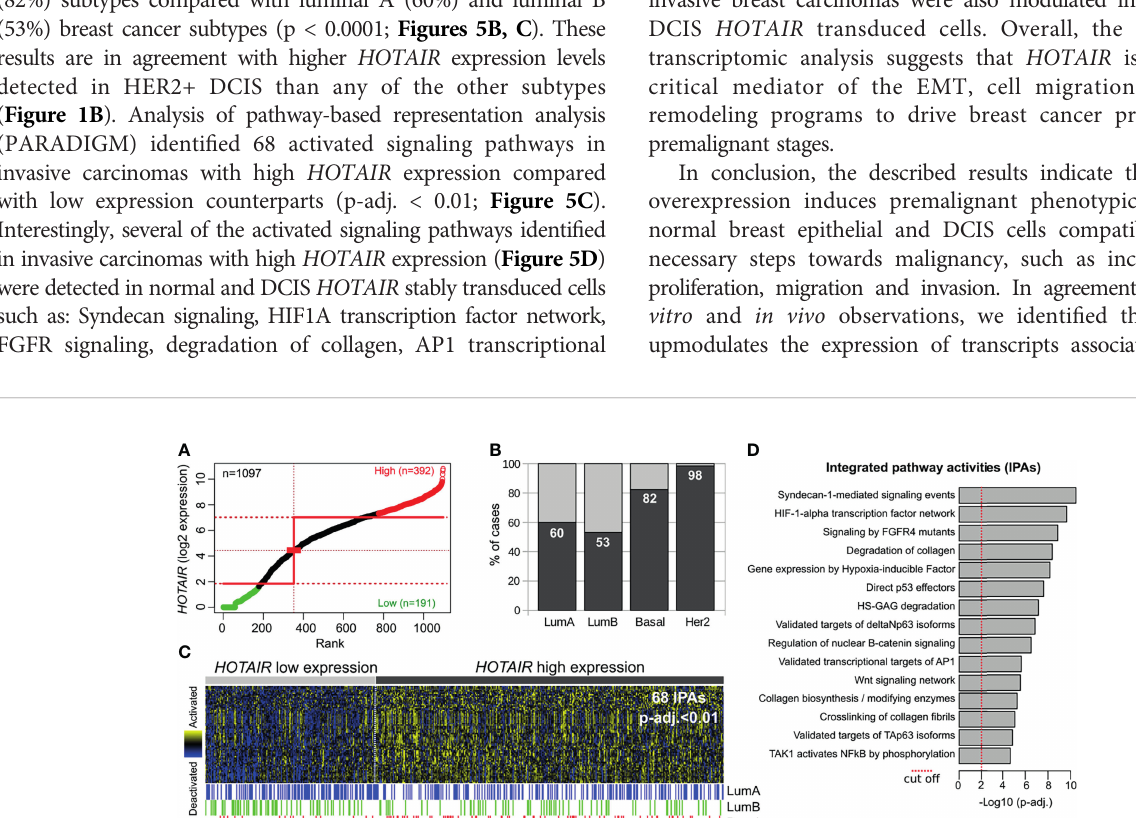
( Figure 1B ). Analysis of pathway-based representation analysis (PARADIGM) identi fi ed 68 activated signaling pathways in invasive carcinomas with high HOTAIR expression compared with low expression counterparts (p-adj. < 0.01; Figure 5C ).